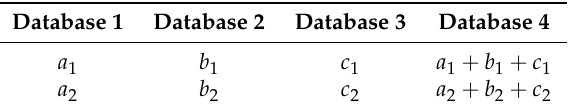
Table 4. Stored variables.